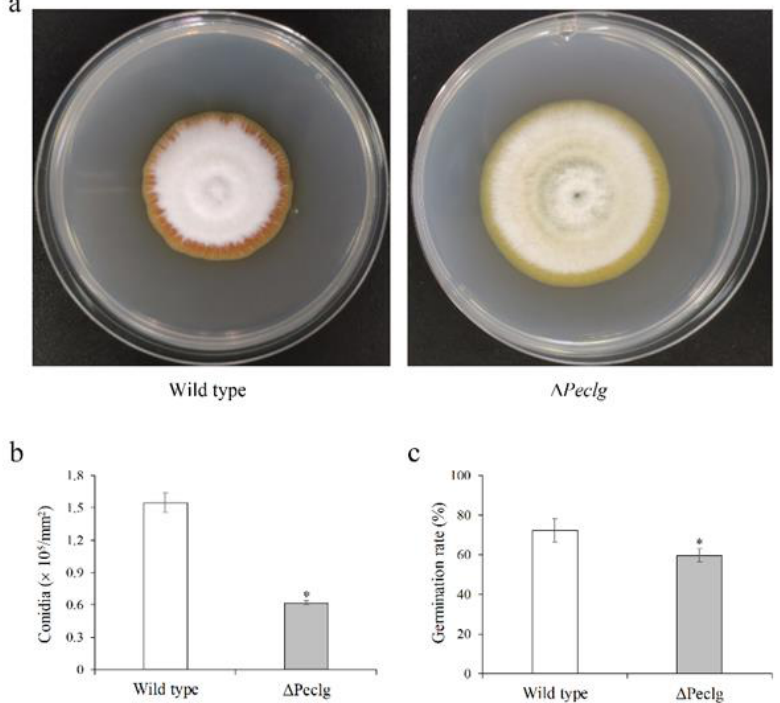
Figure 3. Effects of Peclg gene on ( a ) radial growth, ( b ) conidial production, and ( c ) germination of Penicillium expansum . Data are presented as means ± SD of three replicates. Asterisks indicate statistically significant differences ( p < 0.05) between strains.